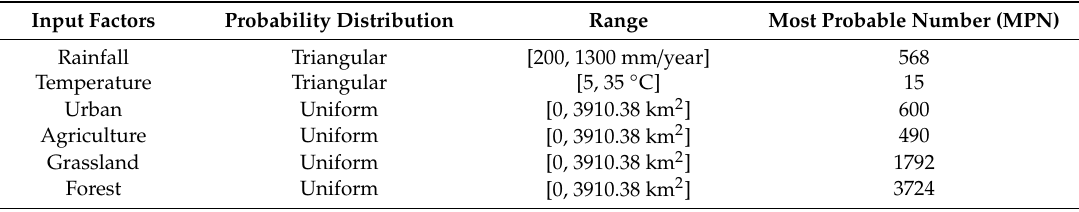
Table 12. Probability distribution and range of